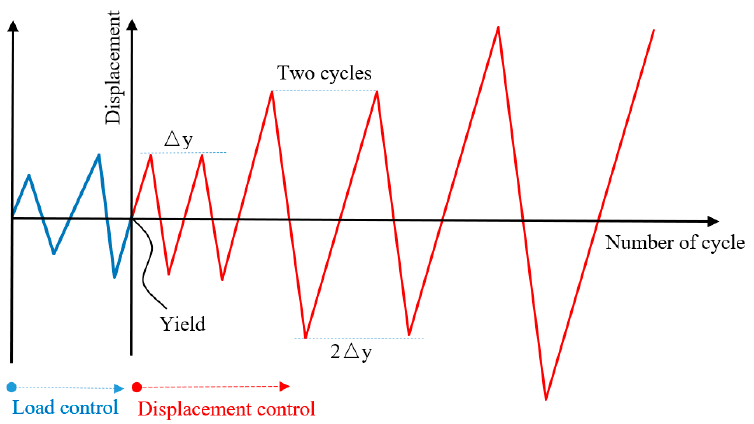
Figure 3. Experimental setup.